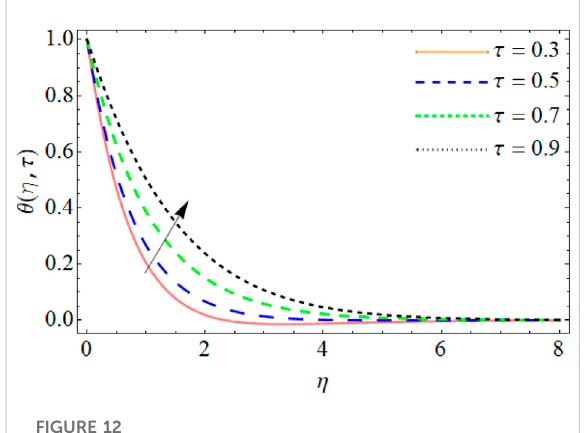
FIGURE 12 Energy outlines θ ( η , τ ) versus parameter τ .